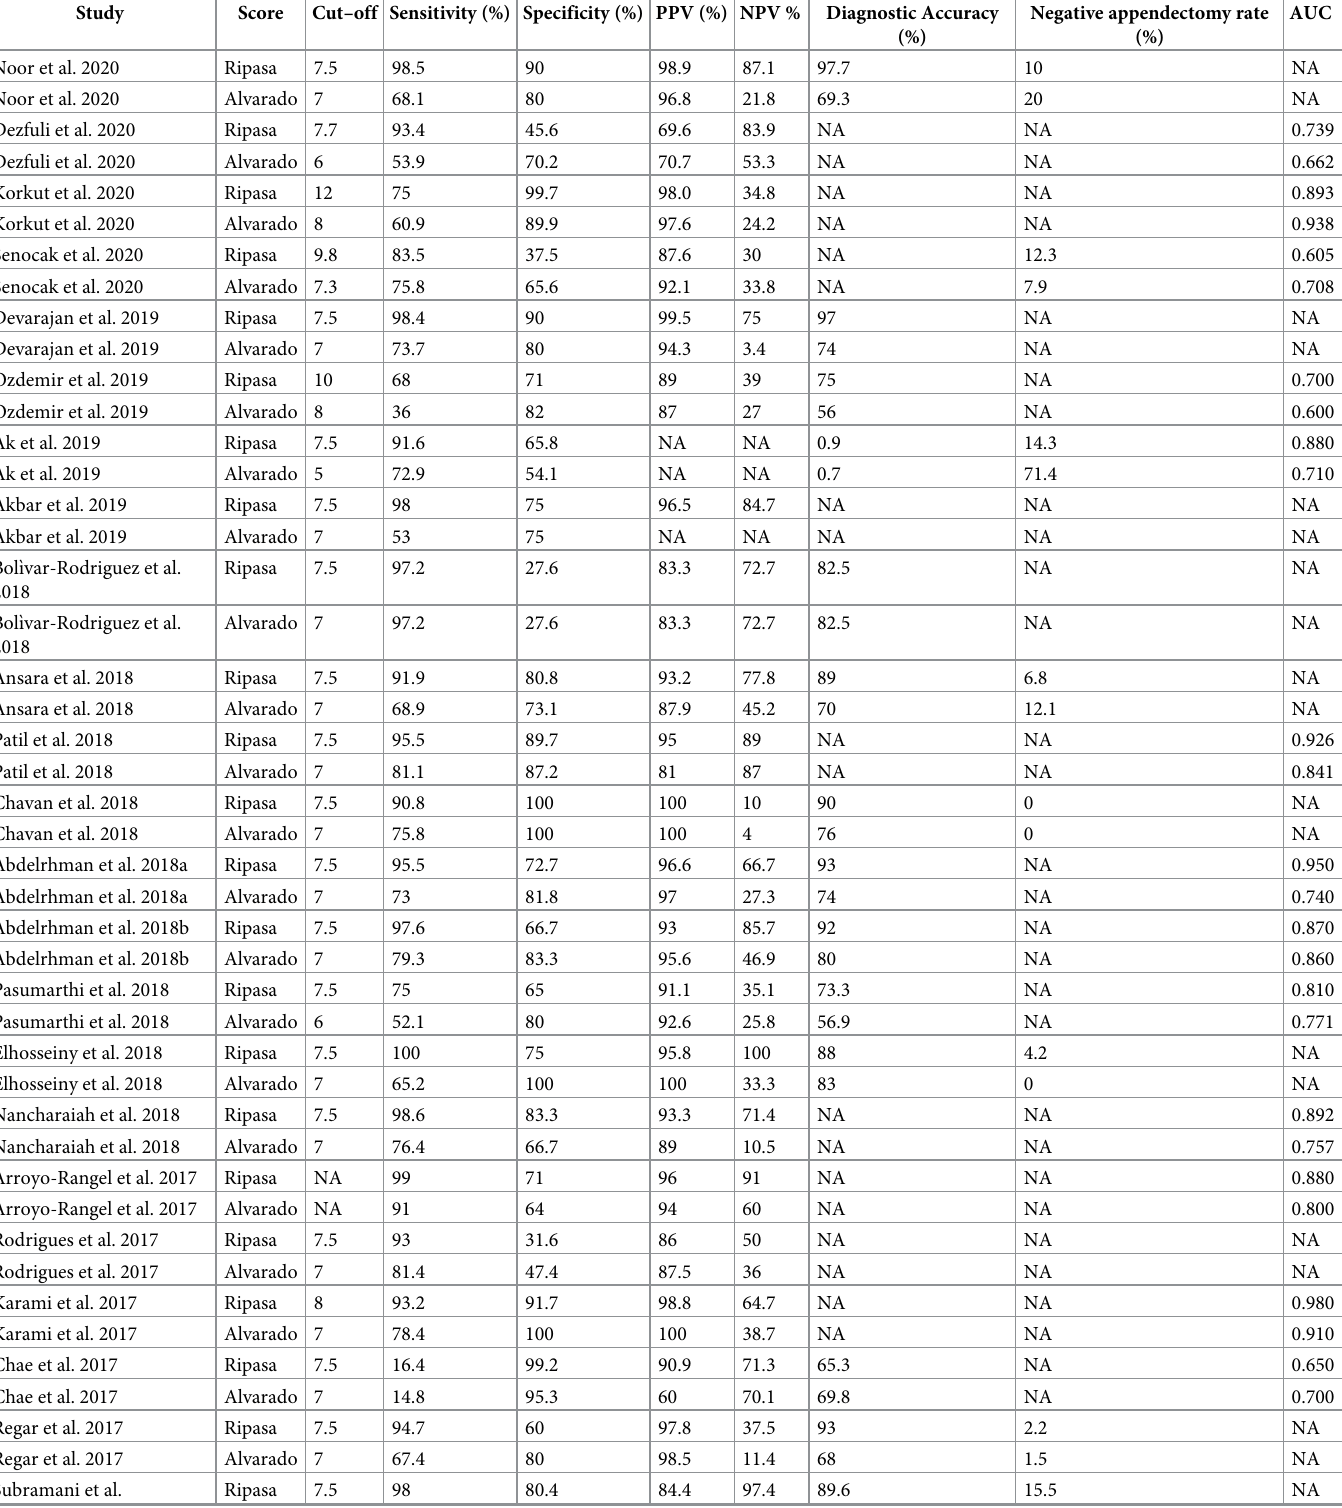
Table 2. Characteristics of clinical scoring systems for each study included in the systematic review.